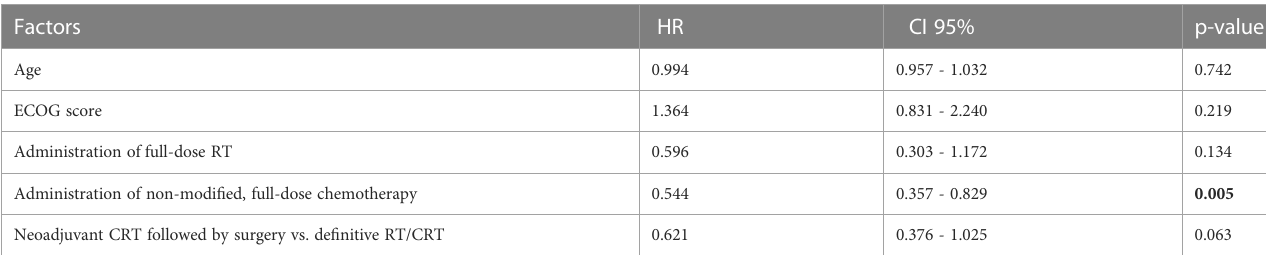
TABLE 3C Multivariate analysis of clinical parameters regarding distant metastasis-free survival (DMFS) of esophageal SCC in elderly patients after de fi nitive or neoadjuvant CRT/RT. Factors